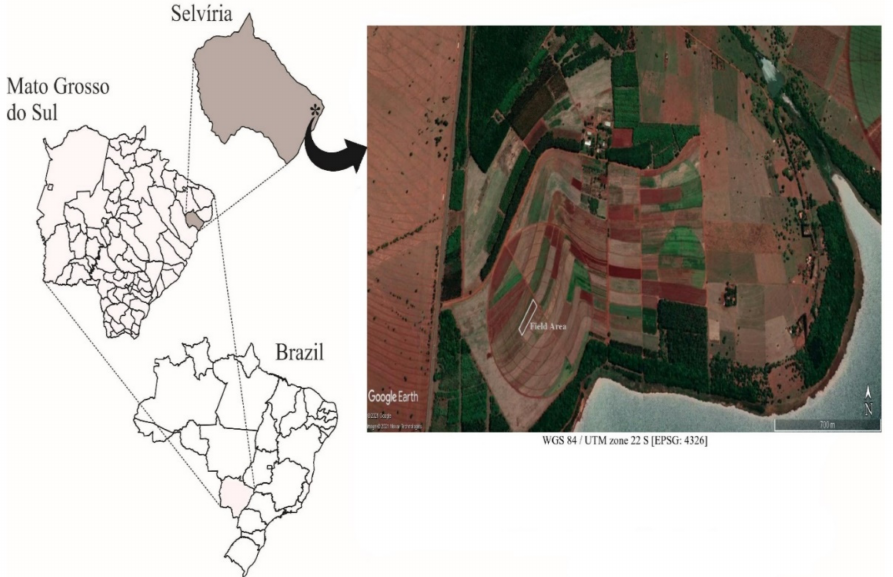
Figure 1. Location of the experimental area at the Research and Extension Farm, UNESP—Ilha Solteira Campus, at Selv í ria—Mato Grosso do Sul state, Brazil (20 ◦ 22 (cid:48) S, 51 ◦ 22 (cid:48) W, altitude of 335 m) in 2019 and 2020 crop seasons. The map was created by using geographic information system (QGIS) software and the Google Earth program. The QGIS Development Team (2021). Open Source Geospatial Foundation project. http://qgis.osgeo.org. Accessed on: 9 March 2021. Projection System WGS 84/UTM 200DC [EPSG: 4326]. This image was taken from the Google Earth program, Google Company (2021). Map data: Google, Maxar Technologies.